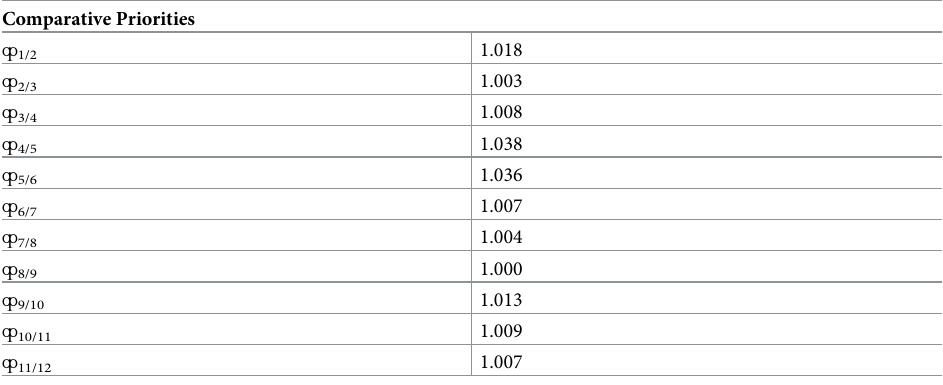
Table 6. Comparative priorities of critical risk